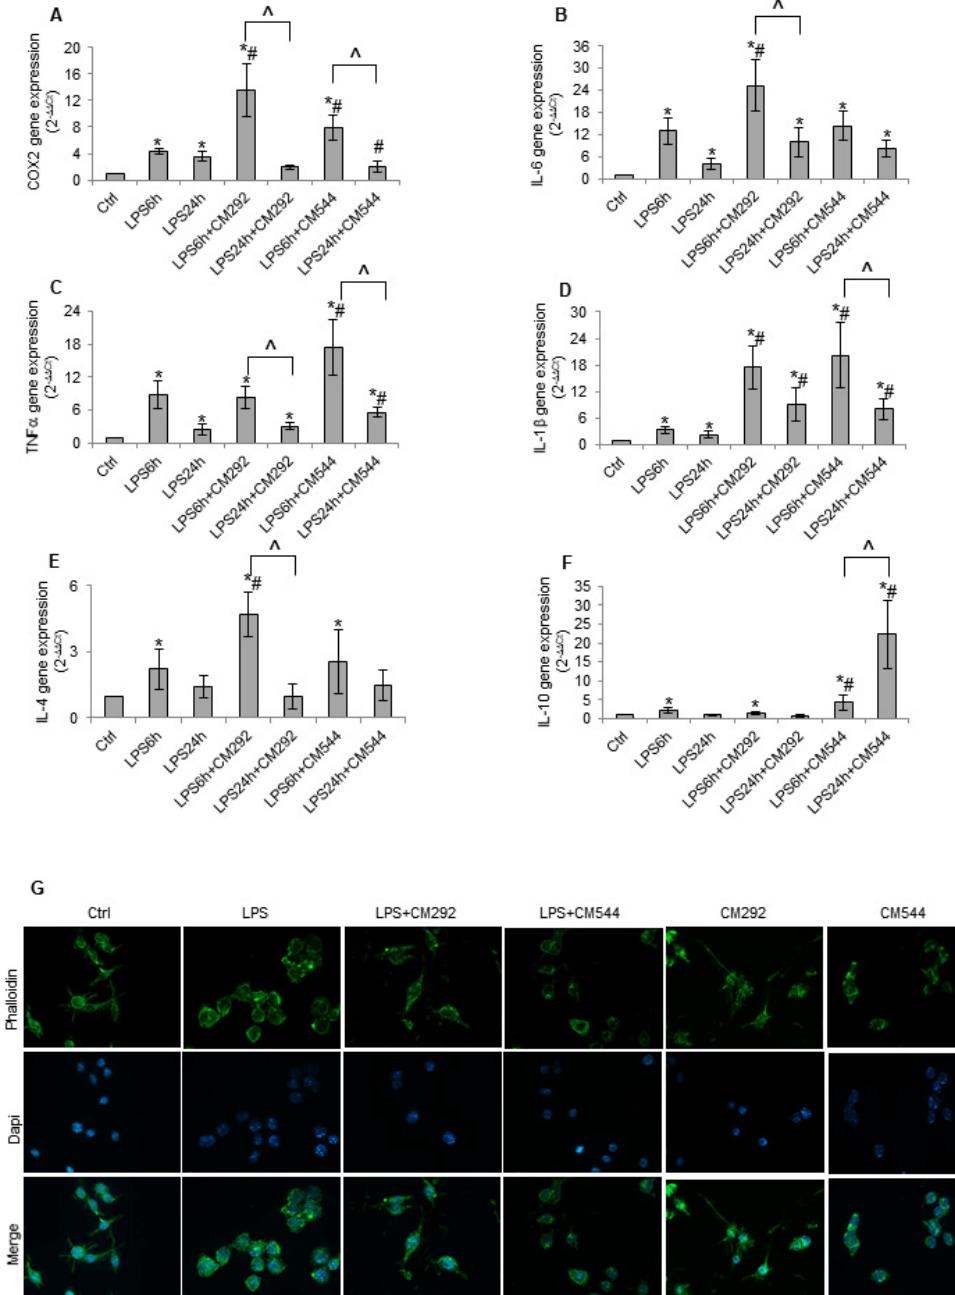
Figure 6. CM292 and CM544 reverted LPS-induced inflammatory response. BV2 microglial cells, pre-treated for 3 h with 10 µ g / mL LPS, were then exposed for various time to 200 µ M of iNOS inhibitors and used for ( A – F ) qRT-PCR of the indicated genes after 6 and 24 h LPS exposure. Gene expression values were normalized to Gapdh and presented as 2 −ΔΔ Ct . Relative mRNA gene abundance in untreated cells was assumed to be 1 (control). Data represent mean ± SD of n = 3 independent experiments performed in triplicate. * p < 0.05 vs. control cells, # p < 0.05 vs. LPS treated cells, ^ p < 0.05 vs. the respective 6h treatment; ( G ) Phalloidin staining after a 24 h exposure. The images are representative of one out of three separate experiments. Magnification 40X.